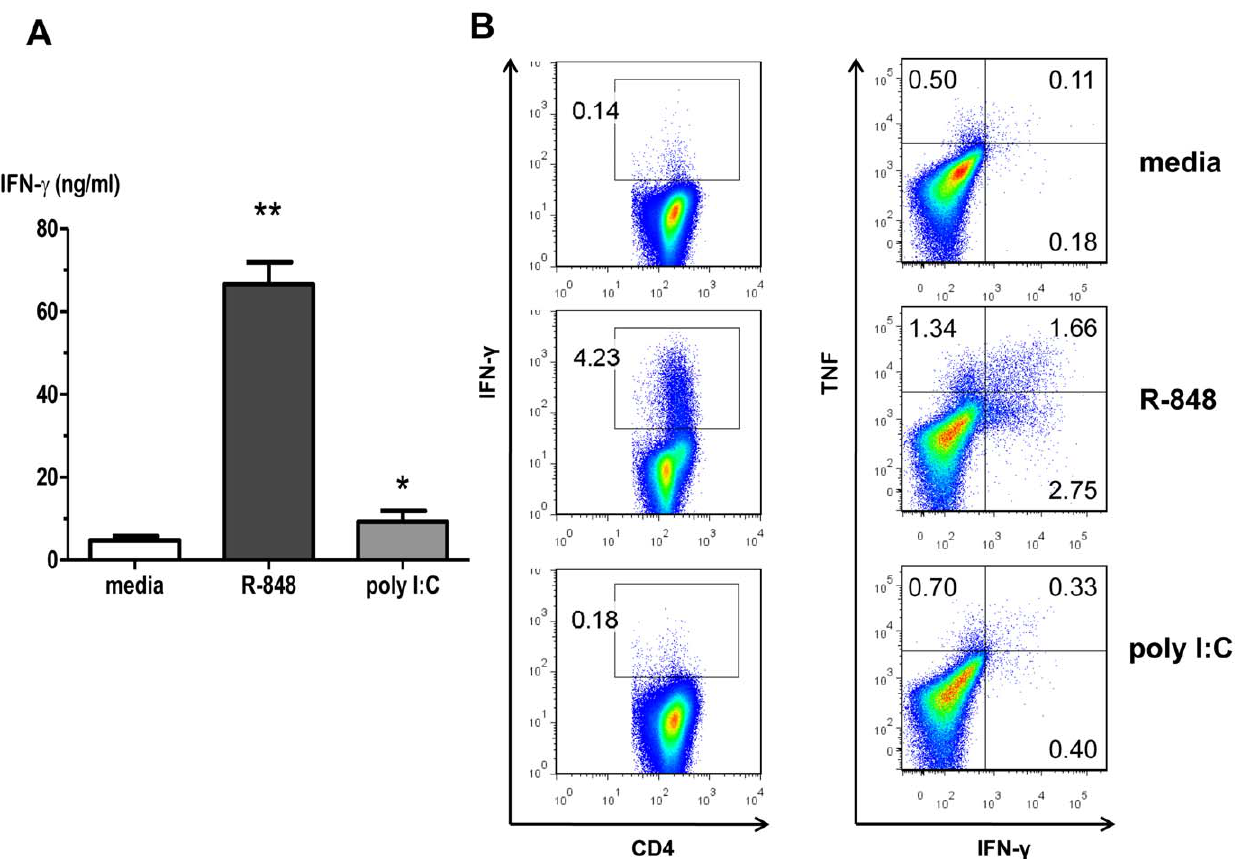
Figure 1. R-848 . poly I:C induces IFN- c + and TNF- a + alloreactive CD4 + T-cells in a MLR. Highly purified bone-marrow derived conventional dendritic cells (cDCs)(CD11c + CD11b + CD45R 2 /lo ) and conventional CD4 + T-cells (CD3 + CD4 + CD8 2 TCRb + DX5 2 ) were co-cultured for 6 d in the presence or absence of RNA-like IRMs. (A) Cell culture supernatant IFN- c levels. Values are mean 6 SEM (n=3), **R-848 p , 0.0001 compared to media control; *poly I:C p=0.0343 compared to media control. (B) ICS staining for IFN- c and TNF- a producing conventional CD4 + T-cells (representative of three independent experiments shown). Values shown are the % of CD3 + CD4 + T-cells producing IFN- c (left column) and % IFN- c + TNF- a 2 , IFN- c 2 TNF- a + , or IFN- c + TNF- a + (right